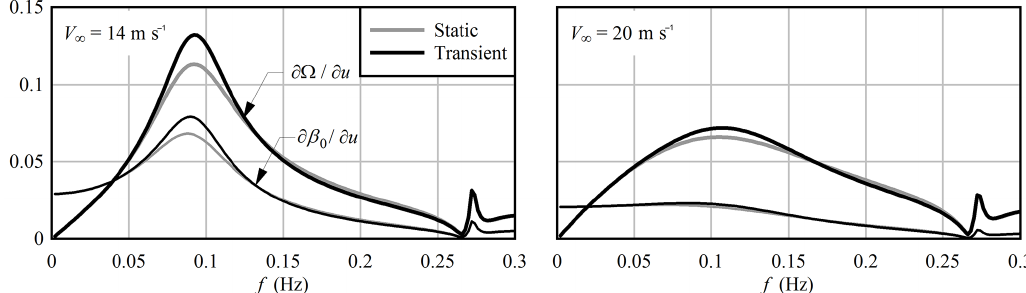
Figure 6. The influence of transient circulation on the closed-loop transfer functions of collective blade pitch and rotor speed with respect to wind speed.